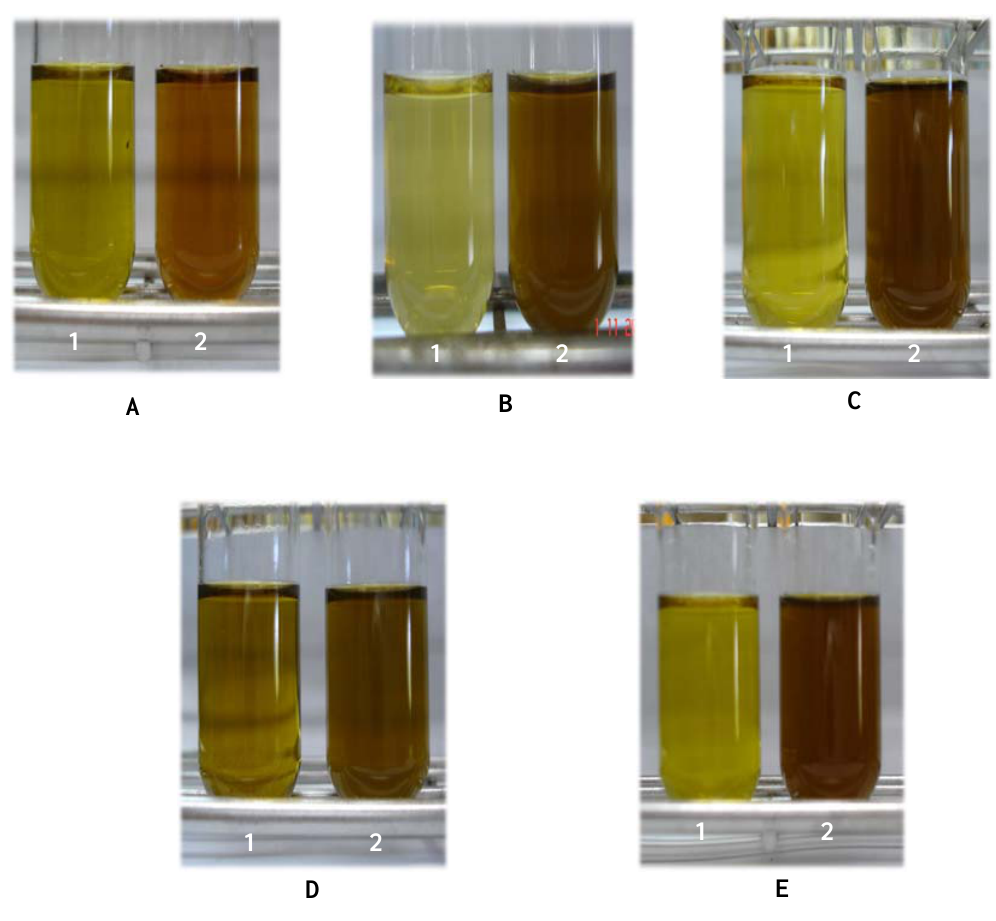
Figure 1 . Plant extracts after dechlorophyllation by (1) electrocoagulation and (2) solvent extraction: A) Solanum laciniatum ; B) Andrographis paniculata ; C) Stevia rebaudiana ; D) Centella asiatica ; E) Cassia siamea